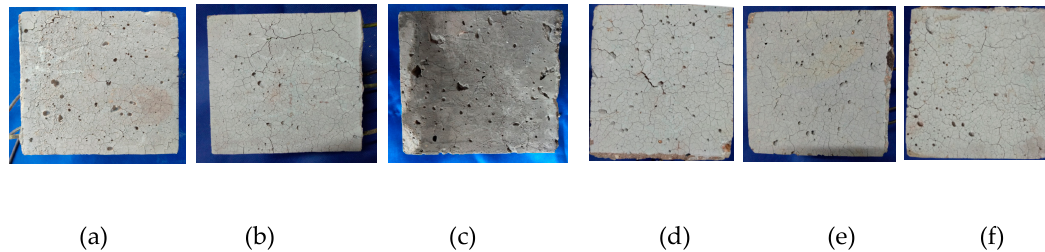
Figure 8. The final state of the P and P + C specimens: ( a ) P2, ( b ) P4, ( c ) P6, ( e ) P1C1, ( d ) P1C2 and ( e ) P2C1.